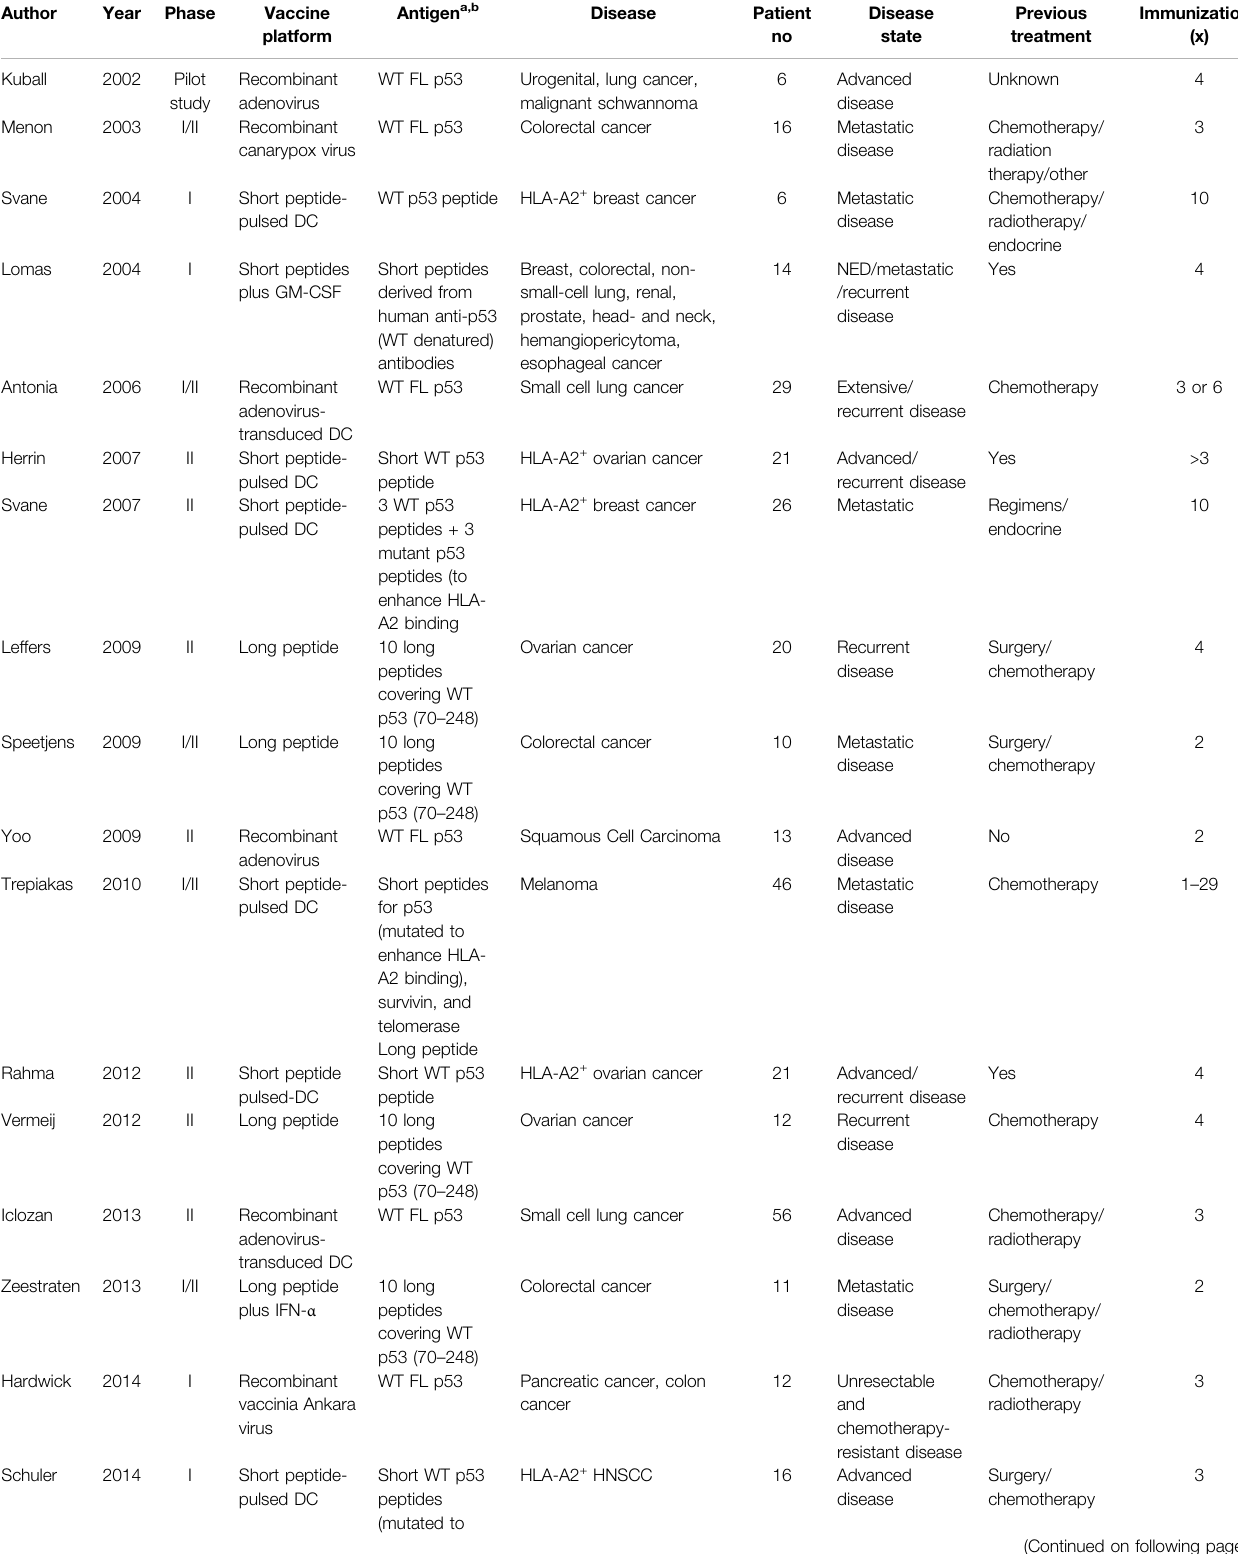
TABLE 1 | Clinical trials with p53-targeting vaccines in human